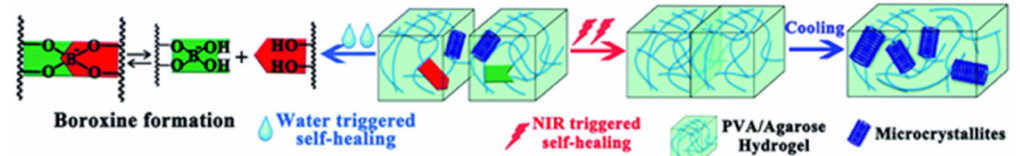
Figure 32. Self-healing mechanisms of the PVA / PDA / MWCNT hydrogel when exposed to NIR and water. Reproduced from [183] with permission from The Royal Society of